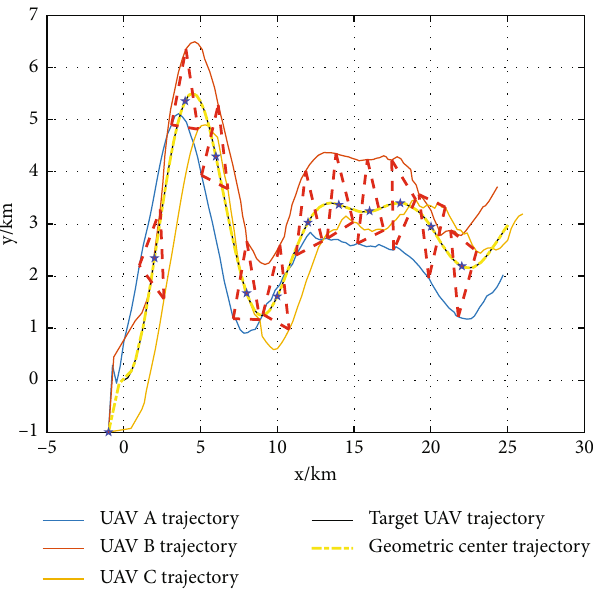
Figure 4: The X - Y coordinate change of proposed algorithm.